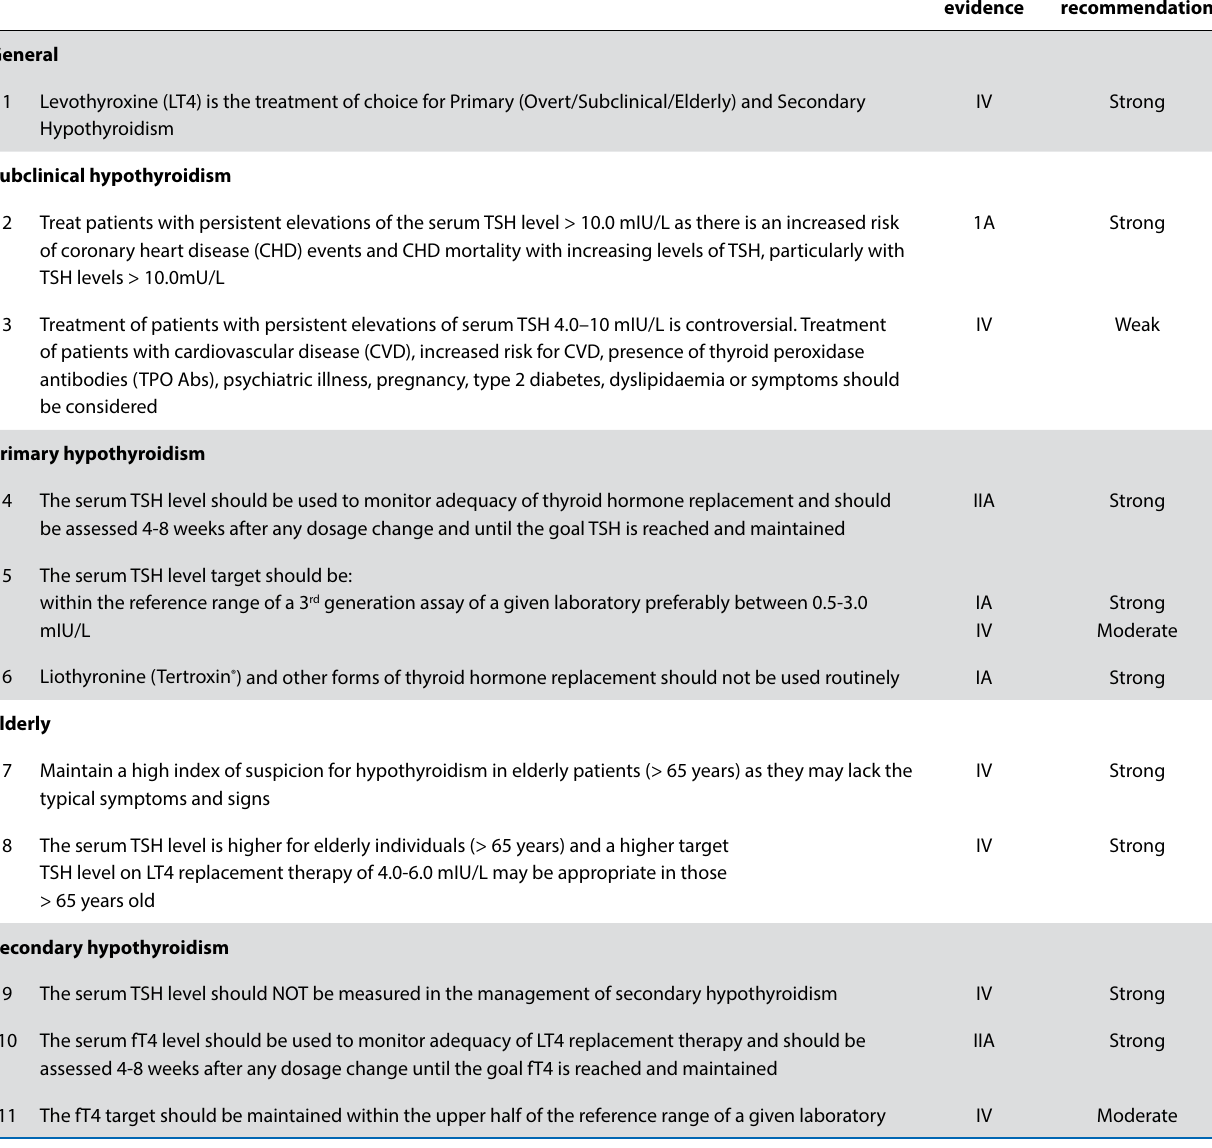
Table I: Recommendations for the management of hypothyroidism